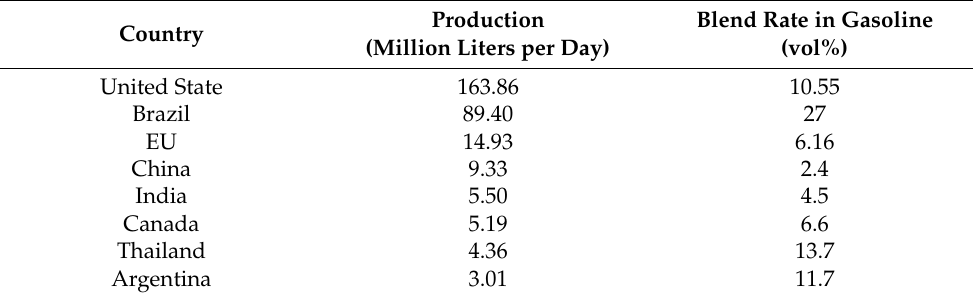
Table 1. The World’s top eight ethanol producers in 2019 and their blend rate in gasoline (Data taken from